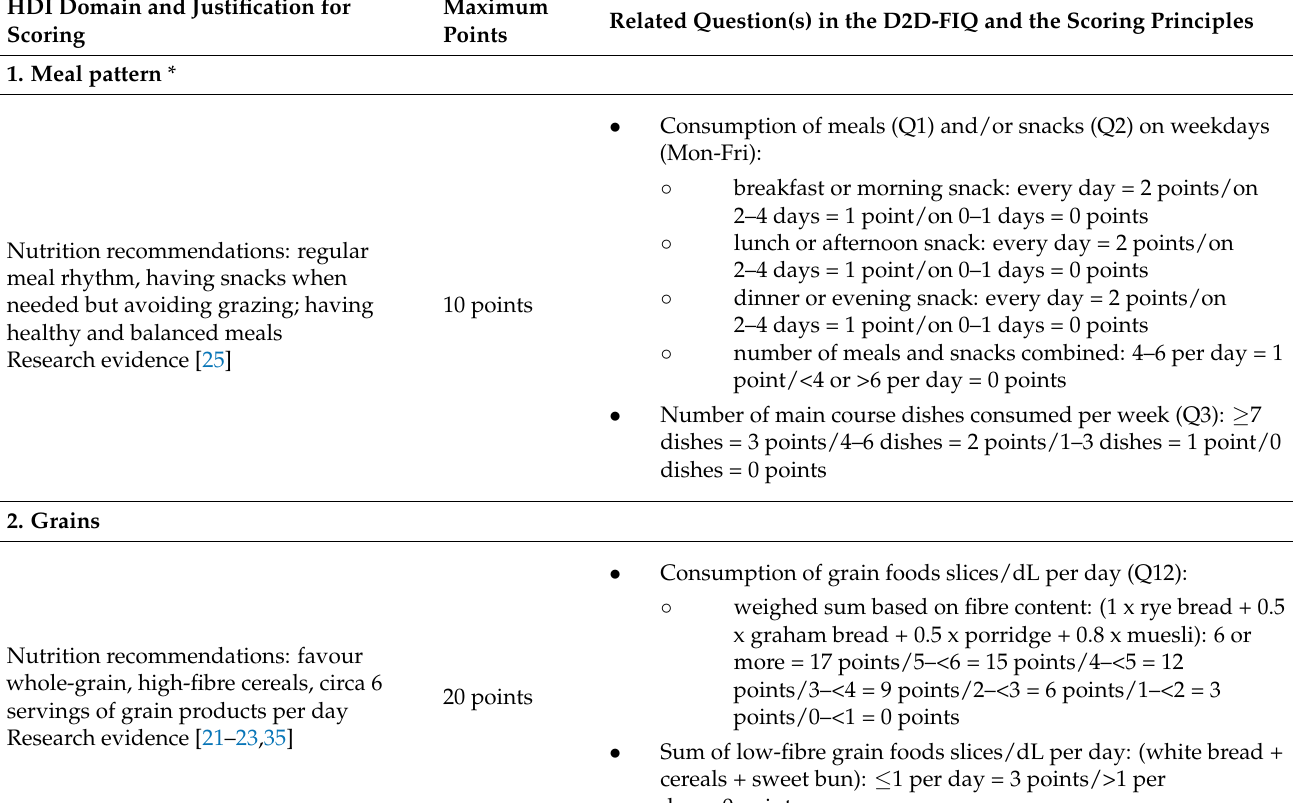
Table A1. Healthy Diet Index (HDI) justification and scoring based on D2D Food intake questionnaire (D2D-FIQ). HDI Domain and Justification for Maximum Related Question(s) in the D2D-FIQ and the Scoring Scoring Points